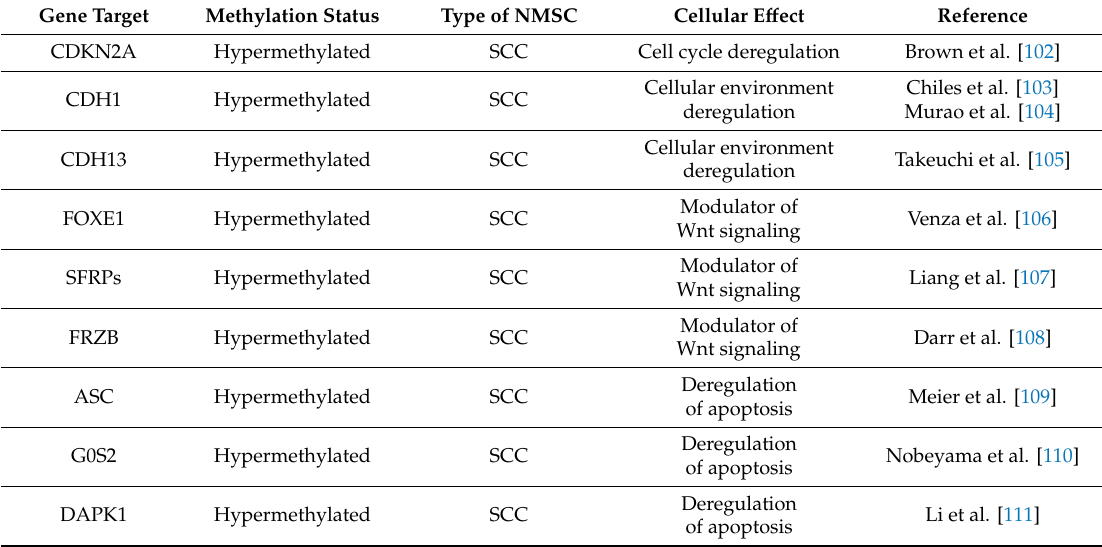
Table 1. NMSC-related genomic loci, their methylation status, and their e ff ect on cellular